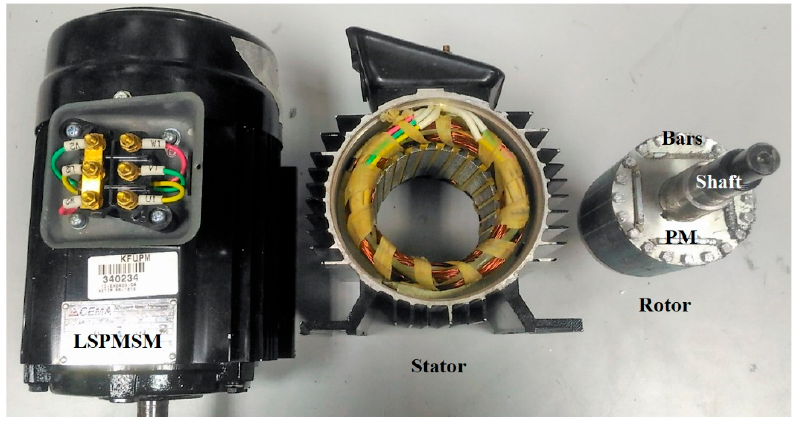
Figure 3. Interior ‐ mount LSPMSM. Figure 3. Interior-mount